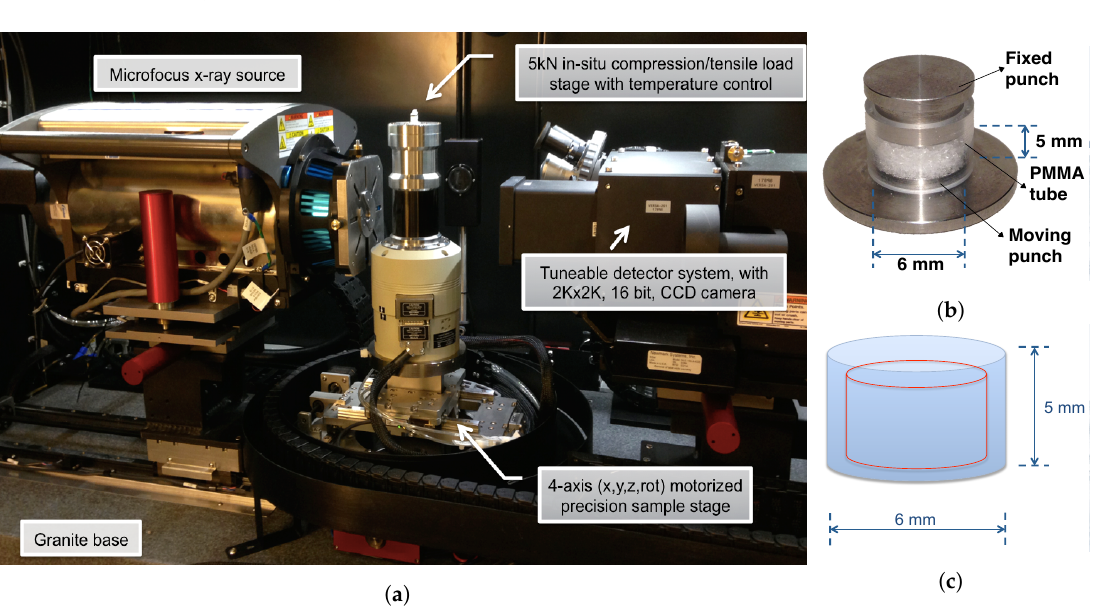
Figure 1. Experimental arrangement of the micro-CT system: ( a ) the micro-CT consists of a sealed microfocus X-ray tube, 4-axis sample stage, a photo detector and a temperature controlled in-situ load stage; ( b ) the sample holder was 6 mm in diameter and 5 mm in height, note that the material visible in the sample holder is sugar; ( c ) selection of volume of interest (VOI) in the snow